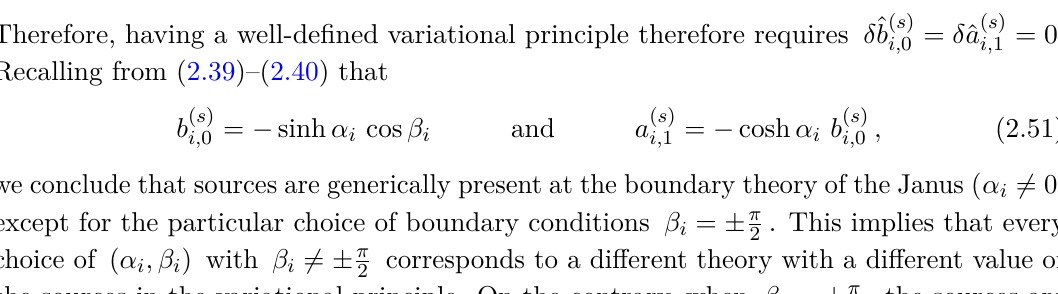
Figure 3 . Parametric plot of ˜ z i ( ρ ) in (2.54) for the Hades solutions with α i = 1 (blue-solid lines) and the ridge flows with α i = 0 (brown-dashed lines) upon setting β i = nπ central red point at ˜ z i = 0 ∀ i corresponds to the maximally supersymmetric AdS 4 vacuum and describes the asymptotic values at ρ → ∞ . The boundary circle at | ˜ z i | = 1 corresponds to the singularity at ρ = 1